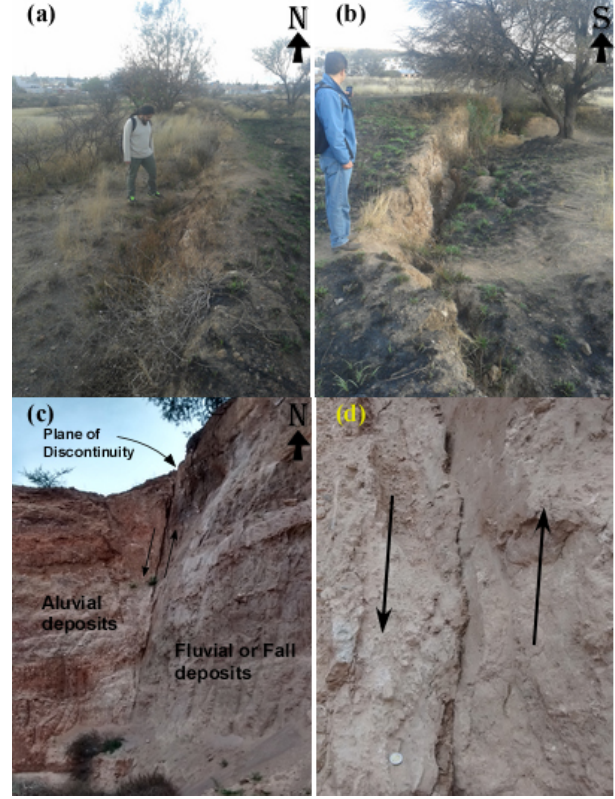
Figure 2. Fotographs depict some characterisitics of the Oriente fault inside the city of Aguascalientes. Difference between the base and the surface in the quarry in panels (c) and (d) is close to